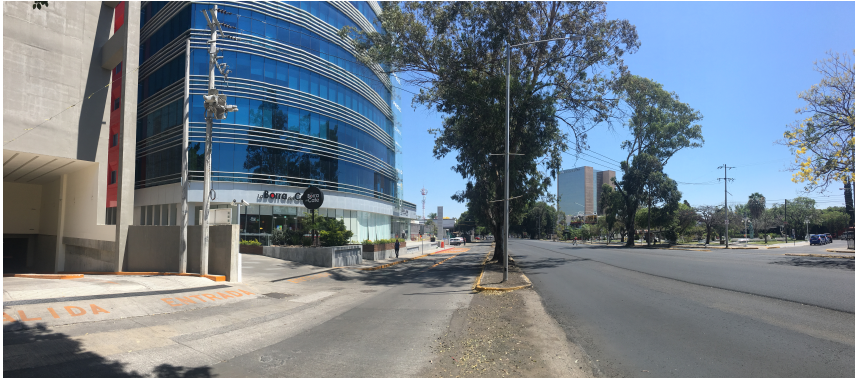
Figure 3. New website design element: preview of a company branch location. Panorama capture.